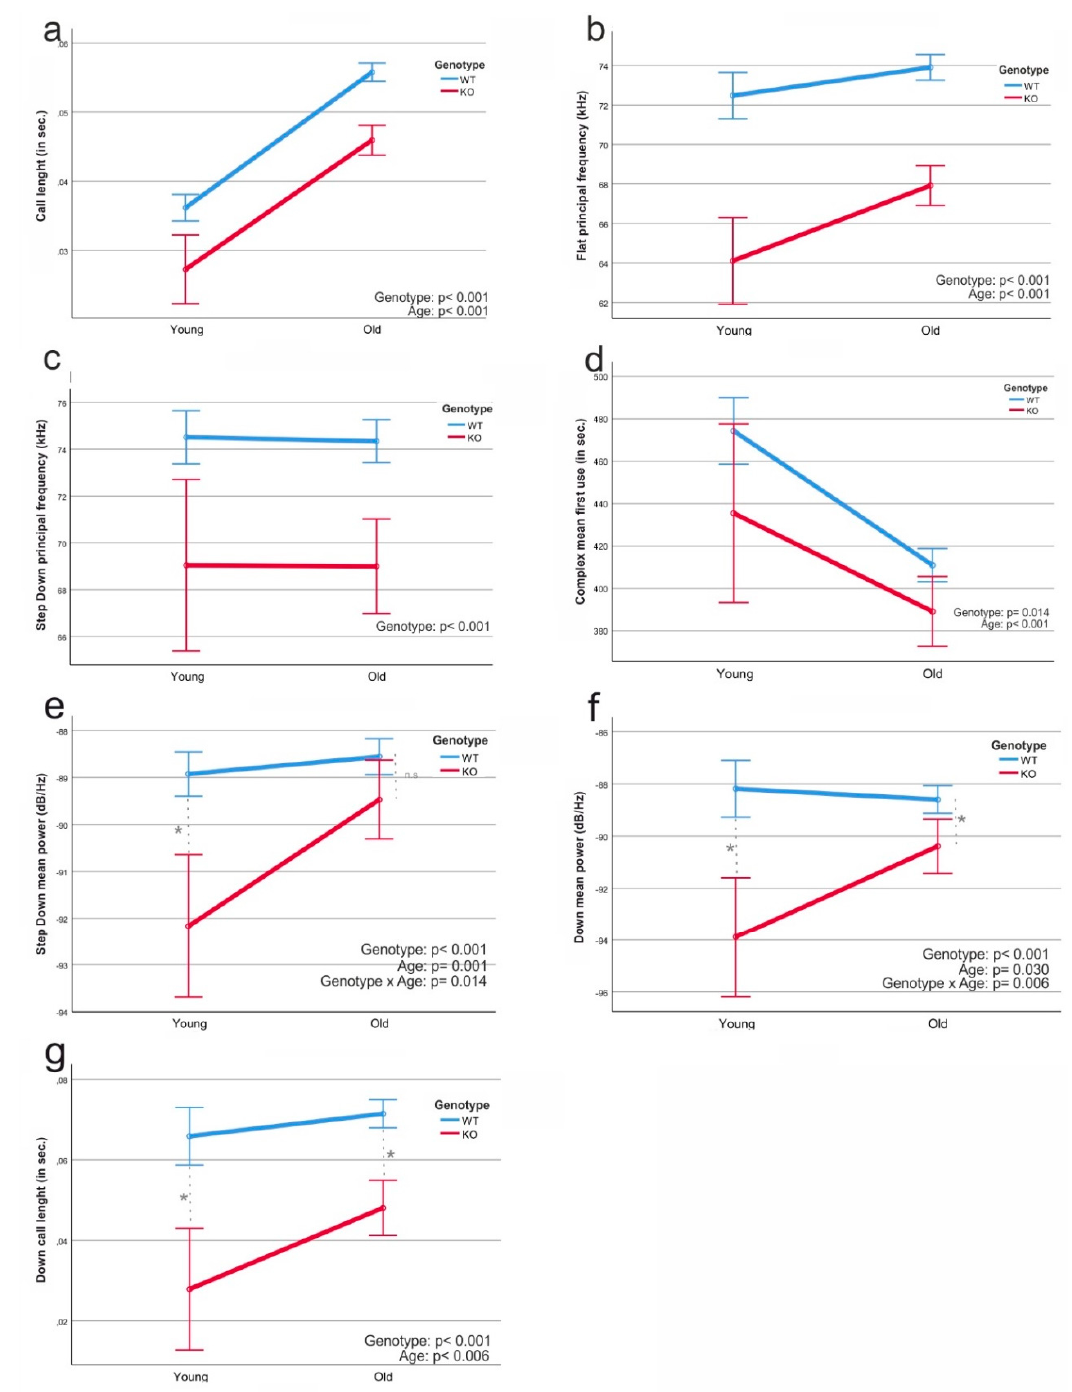
Figure 4. Two-way ANOVAs from different calls and factors of the four test groups. ( a ) Call length: shows the general length of all calls in seconds from WT and KO. ( b ) Flat, principal frequency: shows the development of the basic frequency of the Flat call from WT and KO. ( c ) Step Down, principal frequency: shows the development of the basic frequency of the Step Down call from WT and KO. ( d ) Complex, mean first use: shows the average use of the Complex call at the beginning of the encounter between males and females. ( e – g ) The development of vocalizations of the KO animals in the course of their life. ( e ) Step Down mean power: shows the development of the average strength (dB/Hz) of the call Step Down of the animals at a young and advanced age. ( f ) Down mean power: shows the development of the average strength of the call Down of the animals at a young and old age. ( g ) Down call length: Shows the development of the length of the call Down of the animals at a young and old age. p values as indicated in the figure. * p <